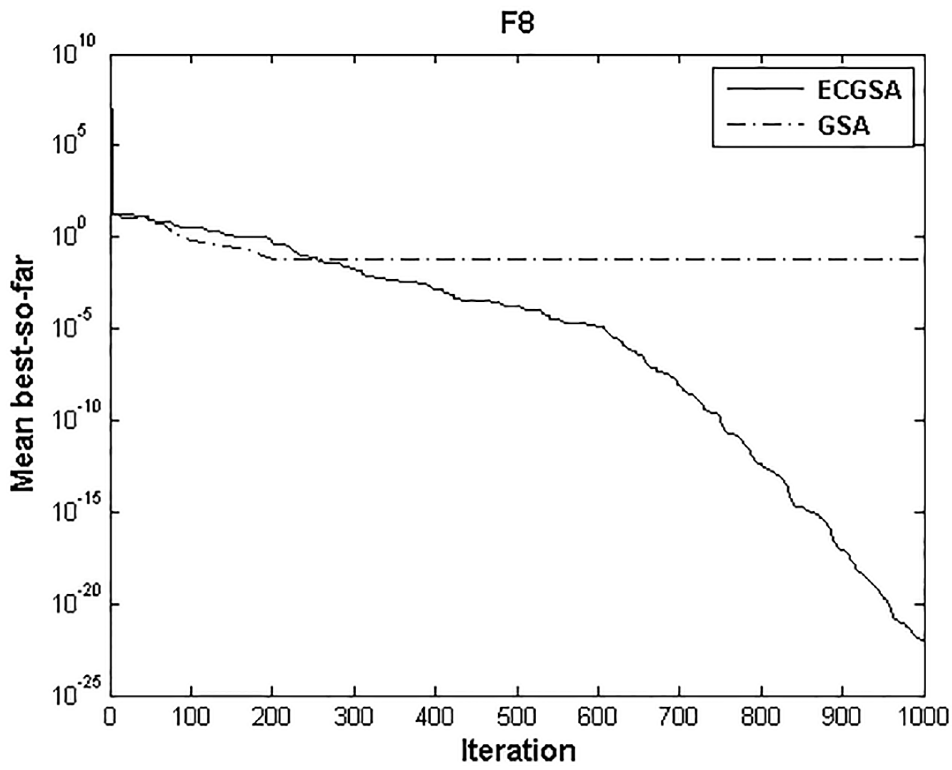
Fig 5. Performance comparison of ECGSA and GSA for F 8.